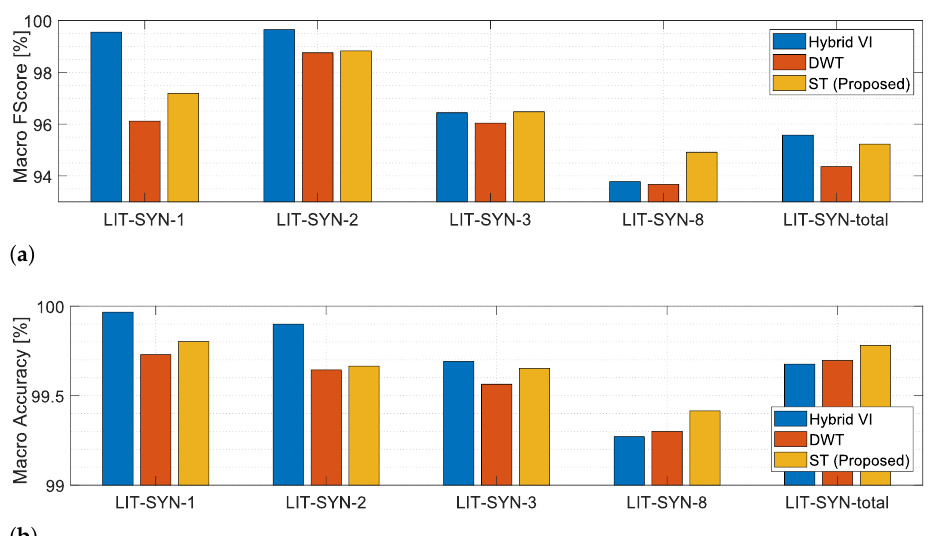
Figure 6. Average of best macro FScores and Accuracies for each LIT subset. Observe that proposed method becomes better than baselines as number of aggregated loads increases. Each bar represents average of all scenarios for correspondent LIT-SYN subset. ( a ) Average of best macro FScores for each Subset. ( b ) Average of best macro Accuracies for each